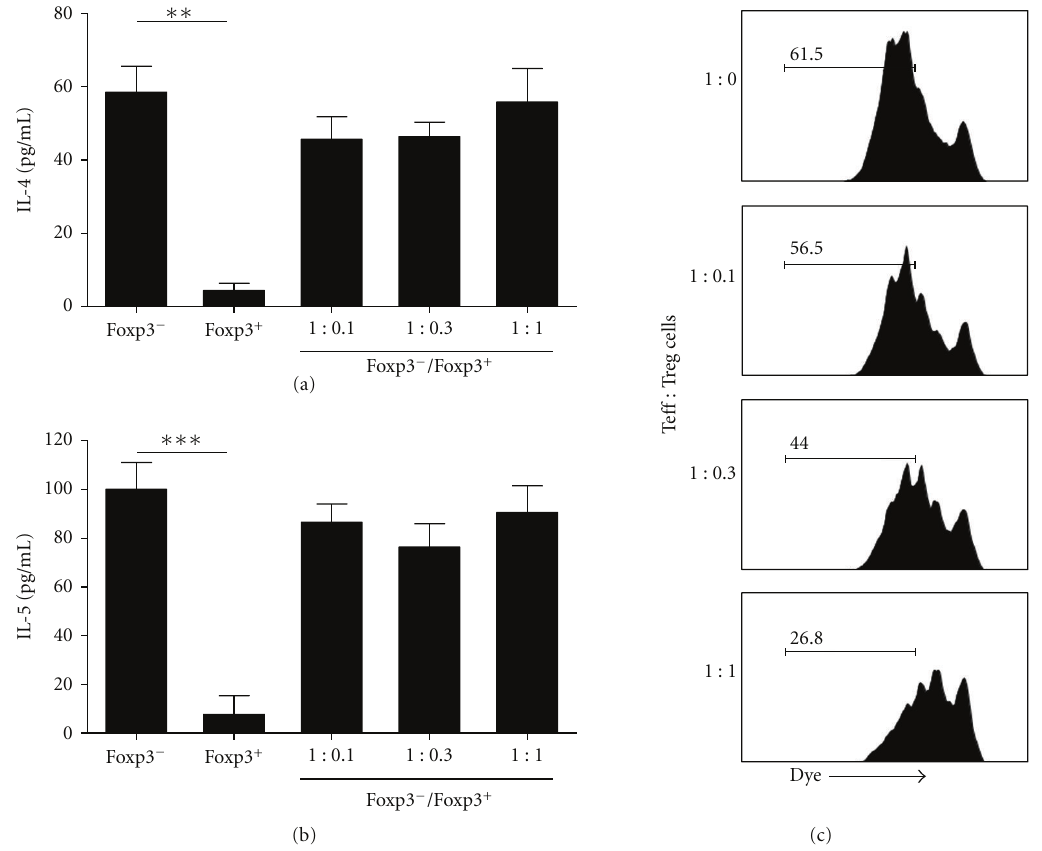
Figure 7: Lung Foxp3 + Treg cells from allergic mice suppress T-cell proliferation but not type 2 cytokine production. (a) IL-4 and (b) IL-5 levels in the supernatants of FACS-sorted lung CD4 + Foxp3-GFP + (Foxp3 + ) or CD4 + Foxp3-GFP − (Foxp3 − ) cells from Foxp3gfp. KI allergic mice alone or cocultured at di ff erent Foxp3 − /Foxp3 + ratios. (c) Proliferation of Foxp3-GFP − cells cocultured at di ff erent Foxp3 − /Foxp3 + ratios was determined by flow cytometry. Sorted lung CD4 + Foxp3-GFP − were labeled with Dye eFluor-670 and the proliferation was determined by reduction of the fluorescence intensity of Dye. Representative FACS-histograms, which indicate the frequency of T-cell proliferation, are shown. Values represent the means ± SEM of triplicate wells. The results are representative of two experiments. Significant di ff erences ∗∗ P < 0 . 01, ∗∗∗ P < 0 . 001 are